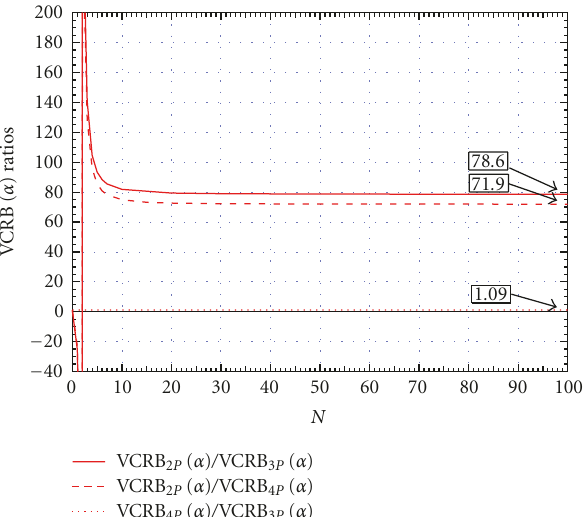
Figure 13: VCRB 2 P ( α ) / VCRB 3 P ( α ), VCRB 2 P ( α ) / VCRB 4 P ( α ) and VCRB 4 P ( α ) / VCRB 3 P ( α ) ratios as function of the total number of pi- lots N